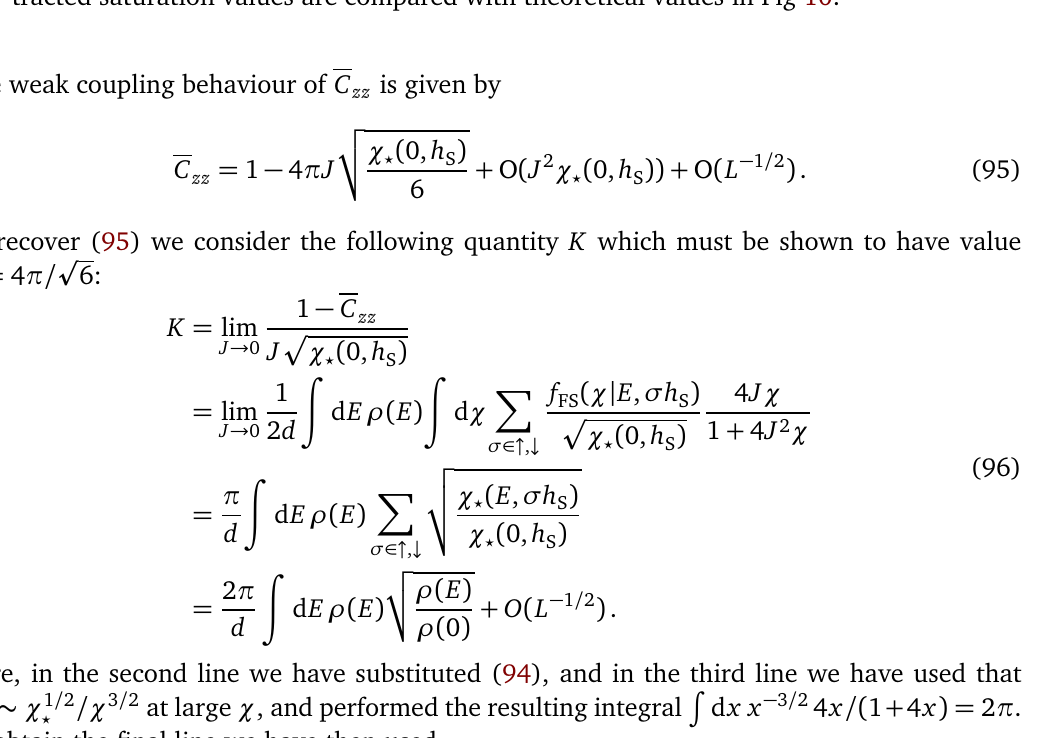
Figure 9: Finite time correlations in the Spin-ETH model for coupling strength J = 0.1 ( t ) initially decays exponen- and different system sizes L (legend). The correlator C zz tially with FGR setting the decay rate (black dashed line). For a finite bath, the en- semble averaged correlations (coloured solid lines) saturate to a finite value which we extract numerically (coloured dashed lines). Individual trajectories (coloured translucent lines) exhibit small oscillations around this value. The numerically ex- tracted saturation values are compared with theoretical values in Fig